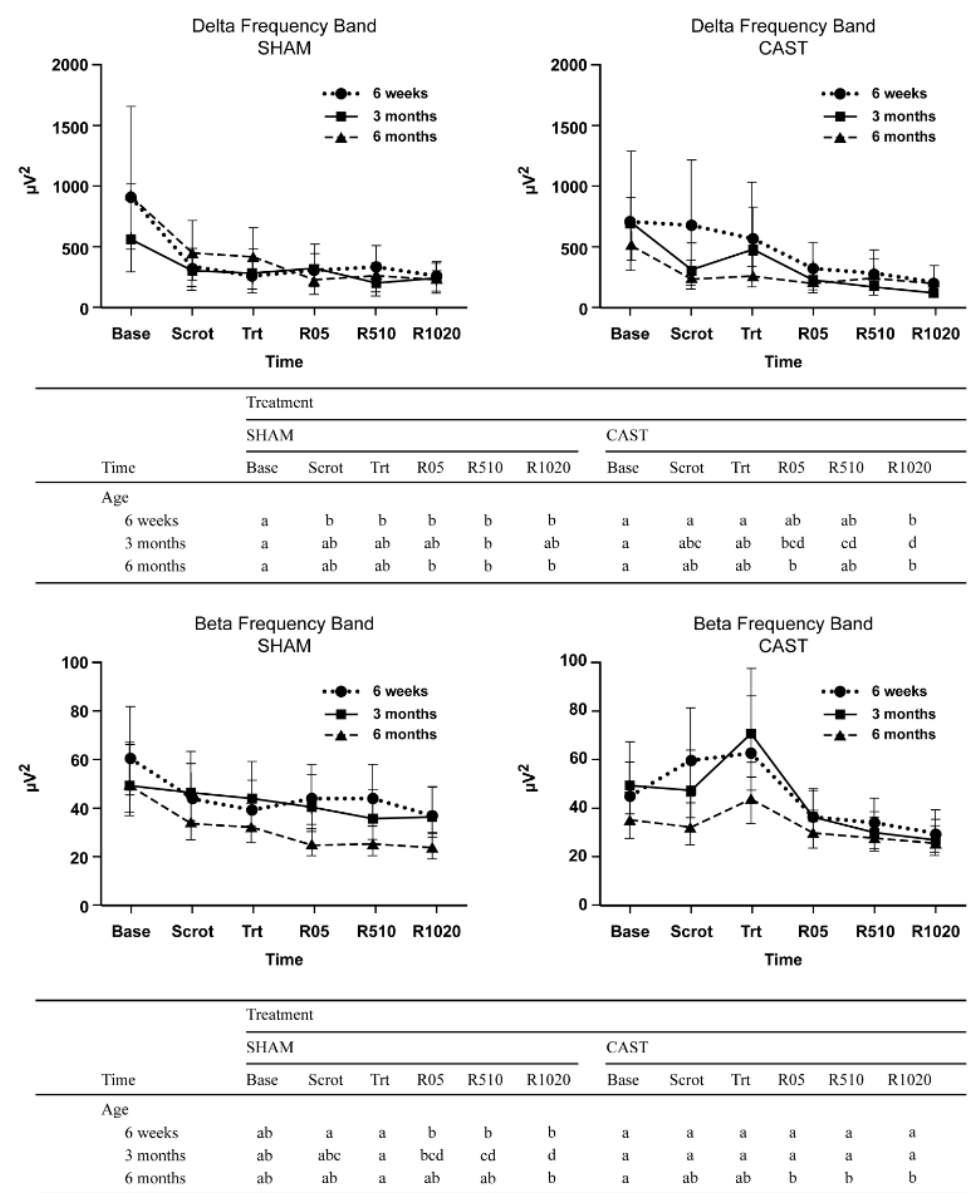
Figure 1. Estimated least-square means and 95% confidence intervals of absolute power ( µ V 2 ) of delta and beta frequency bands for 6-week—(6W), 3-month—(3M), and 6-month-old—(6M) calves undergoing simulated castration (SHAM) and surgical castration (CAST) treatments. Time points evaluated consist of baseline (Base), scrotum manipulation (Scrot), treatment (Trt), immediate recovery (R05), middle recovery (R510), and late recovery (R1020). Letters (a, b, c, d) indicate a significant difference ( p < 0.05) between the time points within each combination of age and experimental treatment along each row in the table.